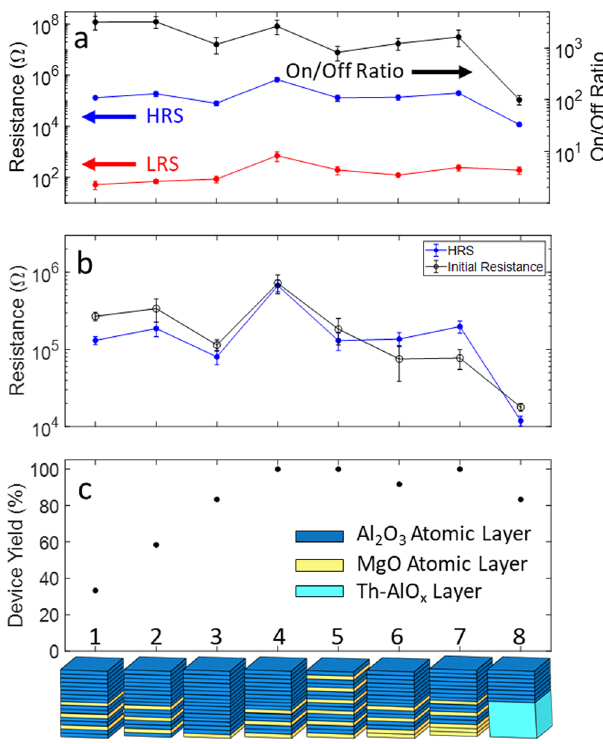
Fig. 7 Effect of M2 layer on memristor performance. a On/Off ratio (black upper), high resistance state (HRS blue middle) and low resistance state (LRS red lower) values, b comparison between initial resistance value and repeatable operating HRS value for various memristors. Device yield for the memristors shown in ( c ). All have the total M1(oxide) + M2(defective oxide) thickness of 17 C (or ~1.9 nm). Sample 8 has 8 C of atomic layer deposition Al 2 O 3 grown on 1 nm thick defective thermal AlO x (M1/M2 thickness ~1.9 nm) . Error bars in a and b are produced from the standard error of multiple measured